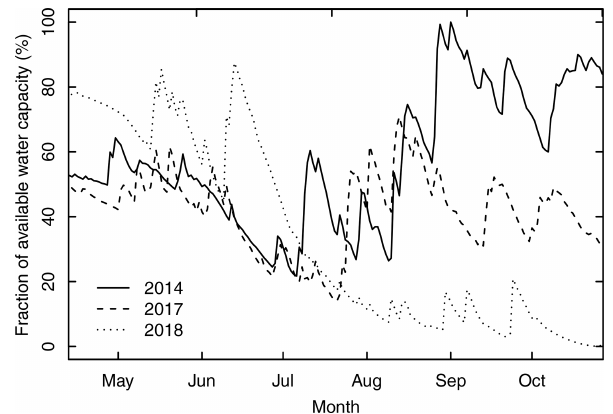
Figure 4. Seasonal patterns of the fraction of available water ca- pacity (AWC 2m ) for a typical steep-slope vineyard in the west of the Rheingau area (near station Ehrenfels, see map in Fig. 1). Simulations were conducted with a water balance model for the years 2014, 2017, and 2018. Parameters for the model input were AWC 2m = 110mm, south oriented, 27.5 ◦ slope, 2m row spacing, one row bare soil, one row cover